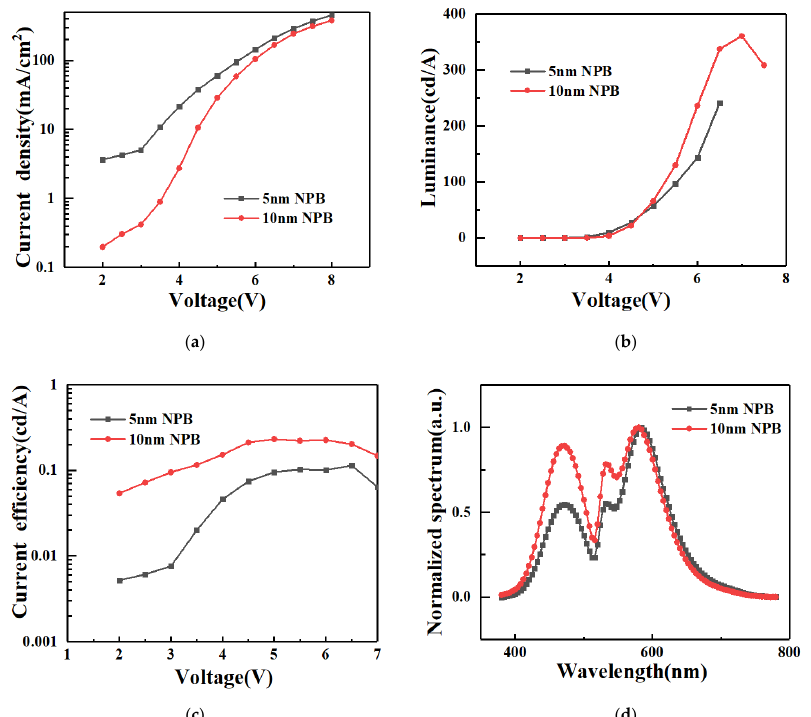
Figure 7. Current–luminance–voltage (I–L–V) characteristic curve and electroluminescence spectra of the white PeLED: ( a ) Current density–voltage (J–V) curve; ( b ) luminance–voltage (L–V) curve; ( c ) current efficiency–voltage (CE–V) curve; ( d ) electroluminescence spectra of the white PeLED